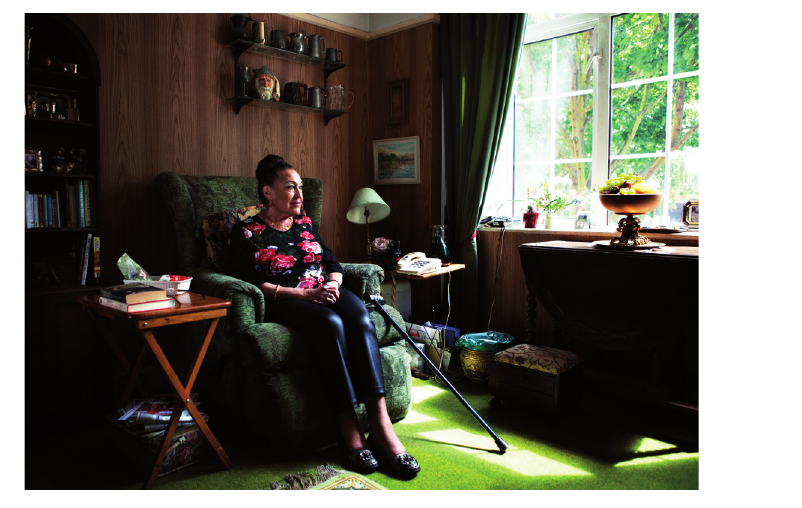
Credit: Hedvig Larsson, 2015